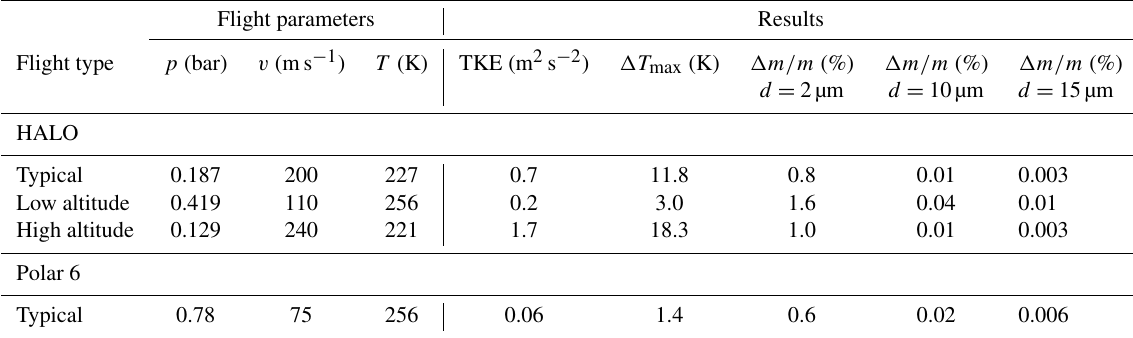
Table 3. Simulation results for different model settings corresponding to possible flight conditions. Turbulence kinetic energy at the detection volume (TKE), maximum temperature difference along the centre trajectory ( (cid:49)T max ) and estimated mass loss due to evaporation ( (cid:49)m/m ) for three different cloud ice particle